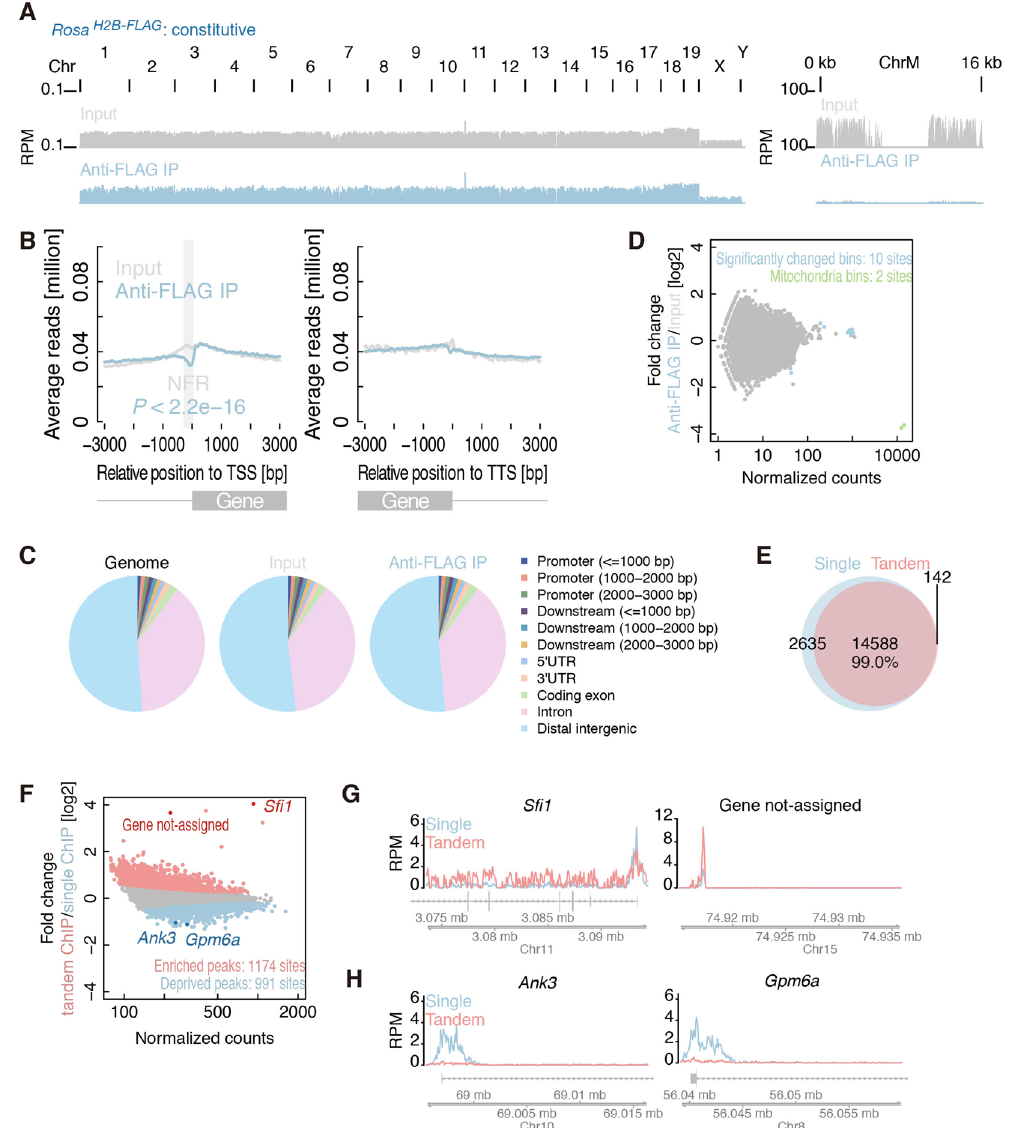
Figure 2. Purification of chromatins by H2B-FLAG. ( A ) Read distributions of input DNA and H2B-FLAG- bound DNA from Rosa H2B-FLAG mice along each chromosome. ChrM represents mitochondria genome. ( B ) Enrichments of reads along the transcription start site (shown at 0 on the x-axis). Significance was calculated by the binominal test. TSS: transcription start site, TTS: transcription termination site. ( C ) Assignment of the origin of reads of input DNA and H2B-FLAG-bound DNA from Rosa H2B-FLAG mice. ( D ) MA-plot of the mean reads in every 10-kbp bin along entire genomes versus their differential changes in anti-FLAG IP compared to input reads. Significantly changed bins (FDR < 0.01) are highlighted in light blue. Bins from mitochondrial genomes are depicted in light green. ( E ) Venn-diagram of peaks called by single H3K4me3 ChIP-Seq and tandem ChIP-Seq from Rosa H2B-FLAG mice. ( F ) MA-plot of the mean read counts in called peaks along entire genomes versus their differential changes in single ChIP compared to tChIP. ( G and H ) Distribution of reads from Rosa H2B-FLAG single H3K4me3 ChIP-Seq and tandem ChIP-Seq along the genomic loci, where biases were observed. RPM stands for reads per